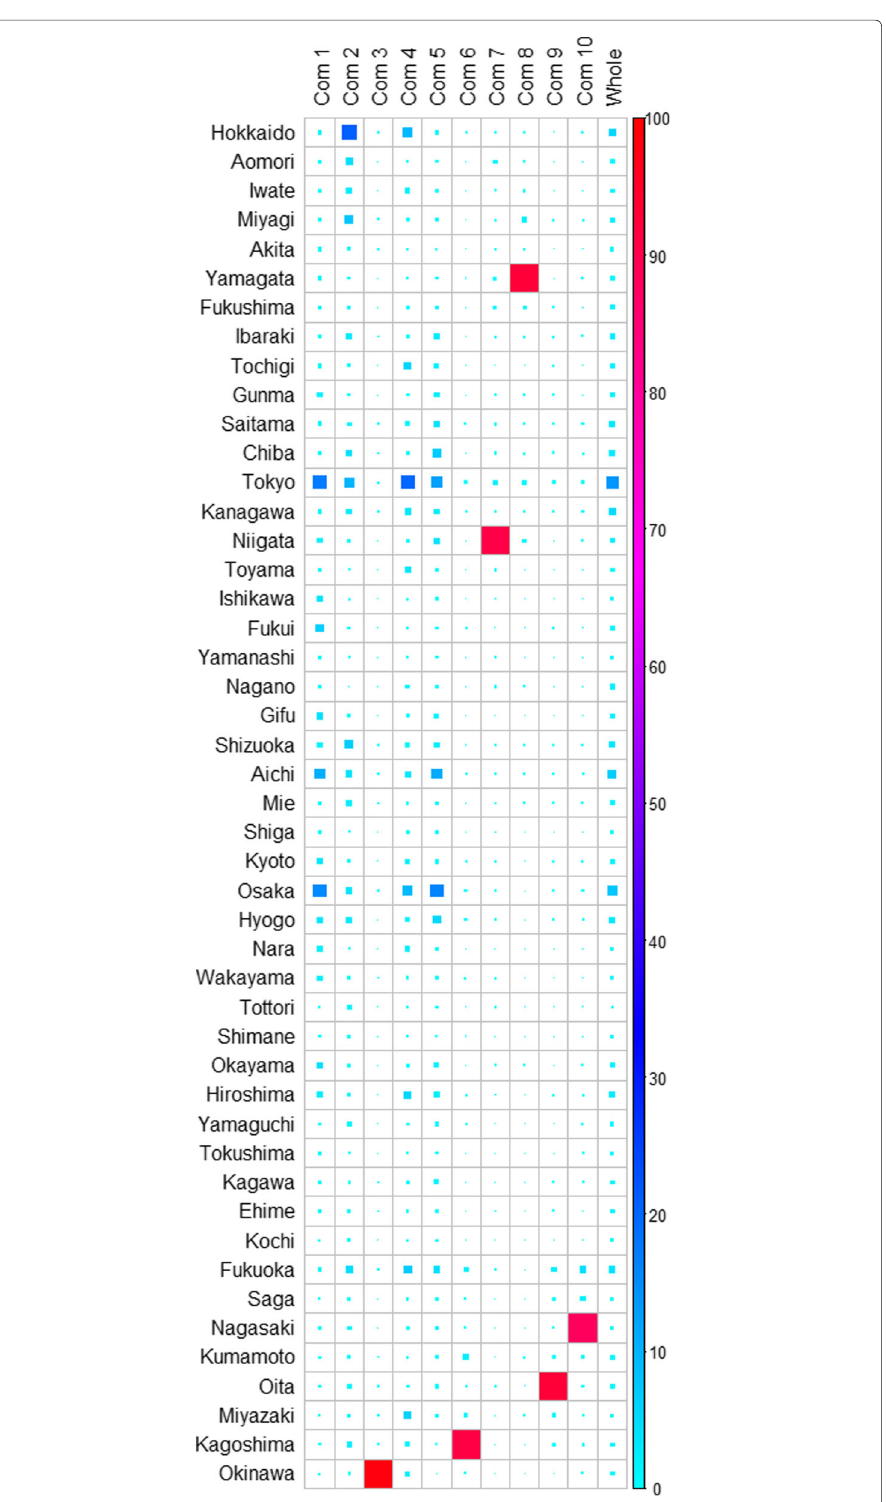
Fig. 14 Regional characterization of the 10 largest communities obtained for the circular flow network on the GSCC by share of prefectures in which their constituent firms are located. The size of each square is proportional to share of the corresponding prefecture in the specified community. Additionally, its share value (in percentage) is represented by the color